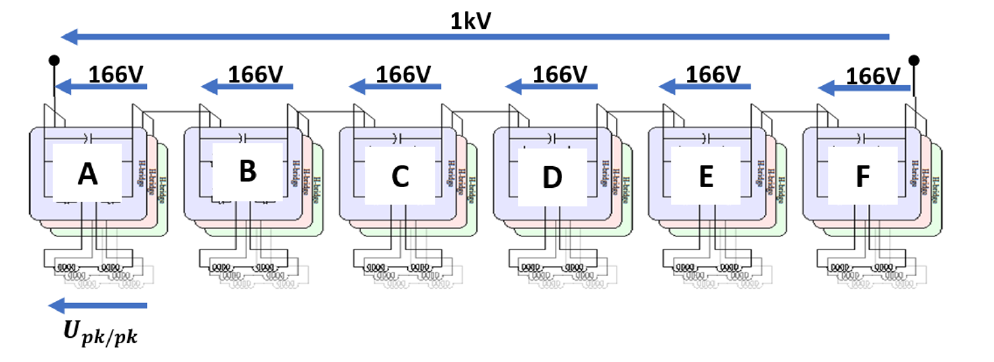
Figure 2. Scheme of the voltage potential distribution along the